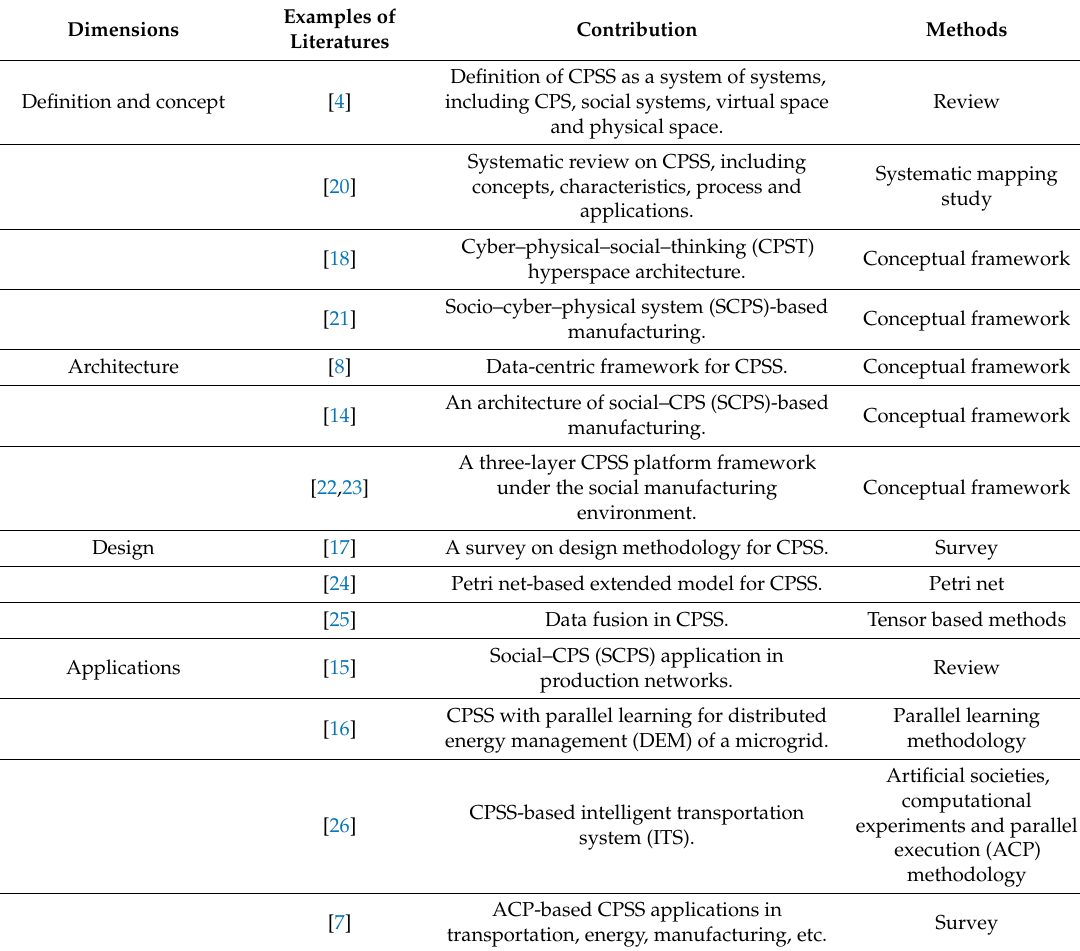
Table 2. Literature on